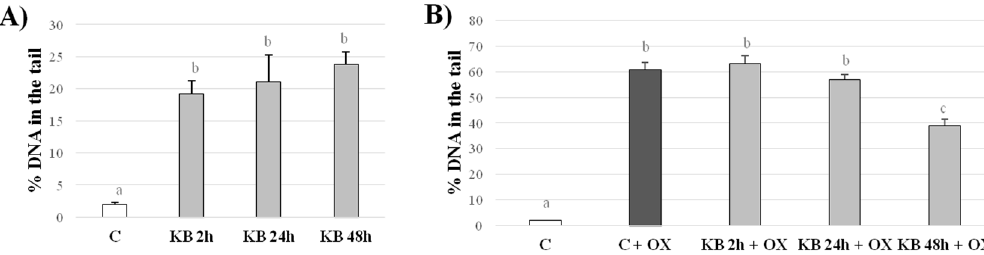
Figure 2. Analysis of DNA damage in HMEC-1 cells treated with KB (4 mM β HB, 1 mM AA) for 2, 24 or 48 h ( A ) and subsequently oxidized with 50 μ M H 2 O 2 for 5 min ( B ); results are expressed as the % of DNA in the tail (mean ± SD). Data not sharing a common letter are significantly different, p < 0.001.